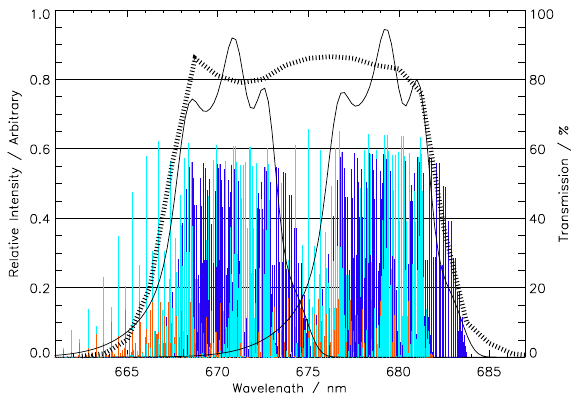
Fig. 4. Relative intensities of synthetic spectra of N 2 first positive (5,2) and (4,1) bands, with the former on the left. The rotational lines are convolved with an instrument function of 0.5nm for a rota- tional temperature of 300K (thin black lines). The ASK1 673.0nm filter transmission curve is superimposed (dashed